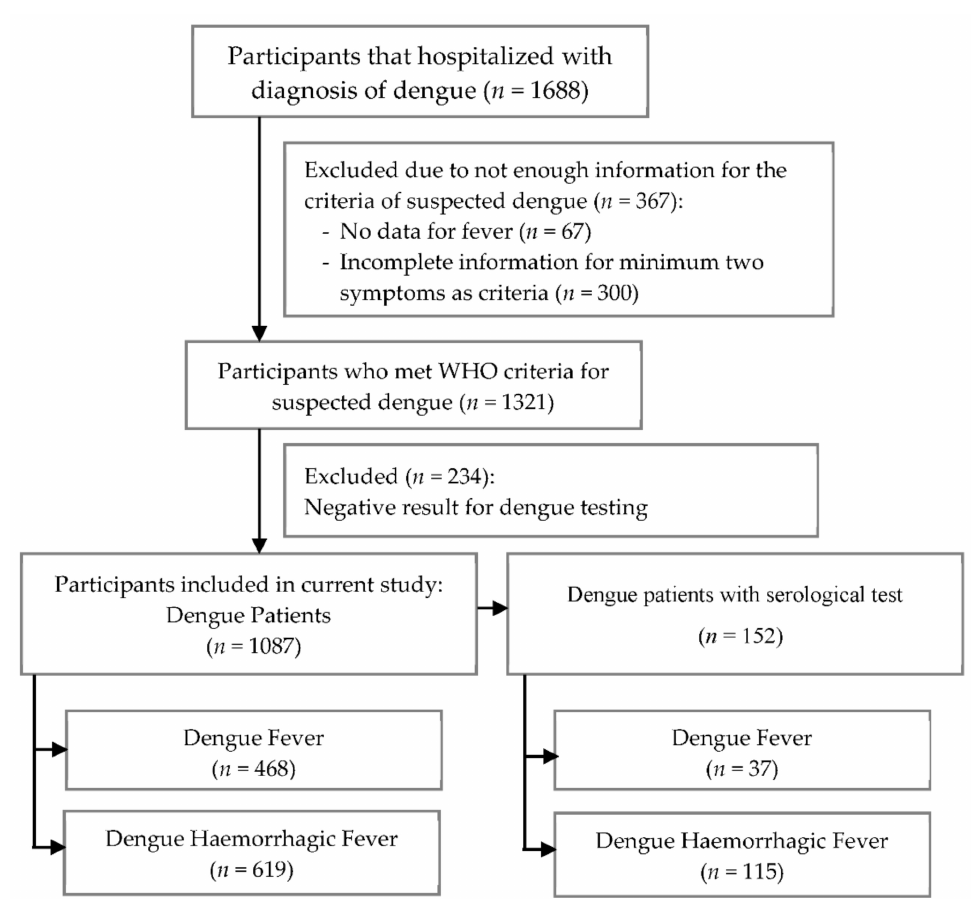
Figure 1. The flow chart for patients’ selection and research